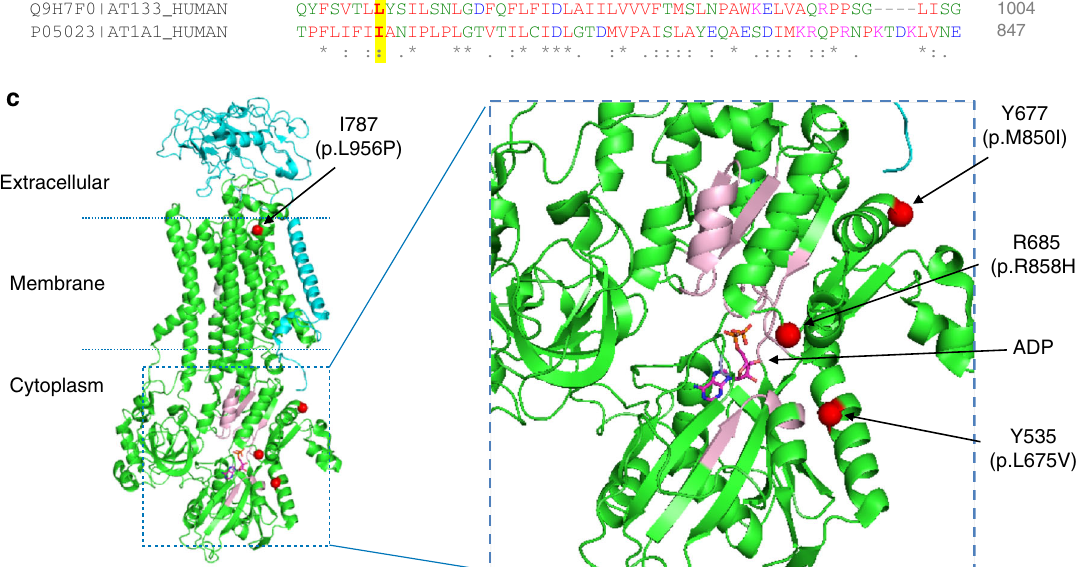
Fig. 6 Structural analysis of ATP13A3 mutations. a Topology of ATP13A3, plotted according to UniProtKB Q9H7F0. Frameshift and stop-gained mutations identi fi ed in PAH cases are shown as khaki circles, and missense mutations as red circles. Frameshift/stop-gained mutations are predicted to truncate the protein prior to the catalytic domain and essential Mg binding sites, leading to loss of ATPase activity. b Sequence alignment of ATP13A3 with ATP1A1 (P05024), of which the high resolution structure was used for the structural analysis in c . The conserved regions of ATP13A3 and ATP1A1, essential for ATPase activity 62 , show good alignment (data not shown). Only regions containing the missense PAH mutations are shown, with positions of the four missense mutations highlighted in yellow above the sequences. c Structural analysis of the 4 PAH missense mutations plotted on the ATP1A1 crystal structure based on the sequence alignment in b (PDB: 3wgu) 63 . Green: α subunit (P05024), cyan: β subunit (P05027), grey: γ -subunit transcript variant a (Q58k79). Y535, Y677, R685 and I787 are the numbering in ATP1A1. Positions of the four missense mutations found in PAH are labelled and highlighted by red circles. d Magni fi ed view of the cytoplasmic region of the ATPase, showing the presence of ADP at the active site. The conserved regions essential for ATPase activity are shown in light pink. The L675V and R858H mutations are located close to the ATP catalytic Heterozygous mutations in GDF2 exclusive to PAH cases comprised 1 frameshift variant and 7 missense variants. GDF2 encodes growth and differentiation factor 2, also known as bone keeping with these predictions, HEK293T cells transfected with morphogenetic protein 9 (BMP9), the major circulating ligand for the endothelial BMPR2/ACVRL1 receptor complex 20 . Amino acid substitutions were assessed against the published crystal secretion of mature GDF2 into the cell supernatants (Fig. 5d), structure 21 of the prodomain bound form of GDF2 (Fig. 5). Variants clustered at the interface between the prodomain and